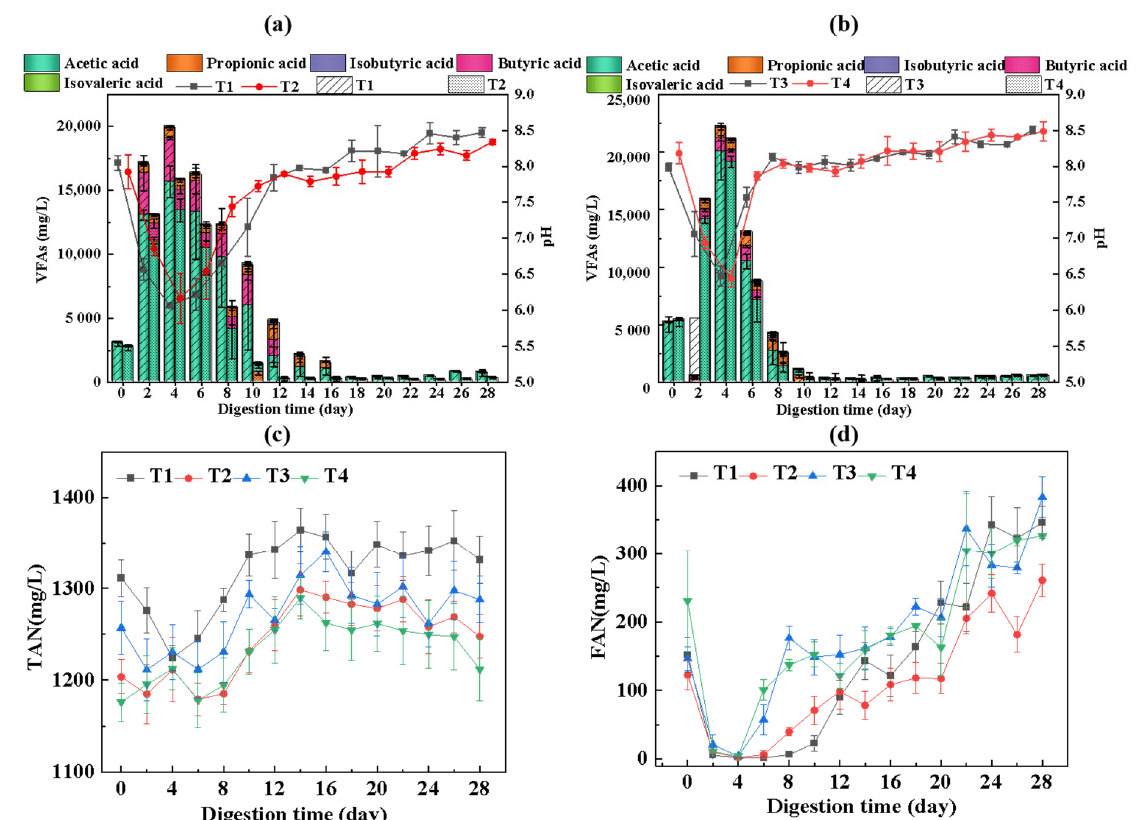
Figure 4. Physicochemical characteristics of F-CS and D-CS digesters during AD, which includes ( a ) changes of VFAs concentration in high S/I ratio system, ( b ) changes of VFAs concentration in low S/I ratio system, ( c ) changes of TAN concentration, ( d ) changes of FAN concentration.